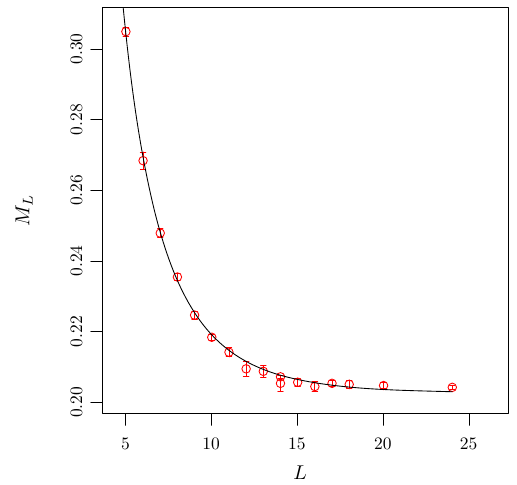
Fig. 3 M L as a function of L . The solid line represents a fit of Eq. (18) to the data in the fit range [ 4 , 24 ] a L = a + O ( e − ML / L 1 / 2 ) , and so on. One can use